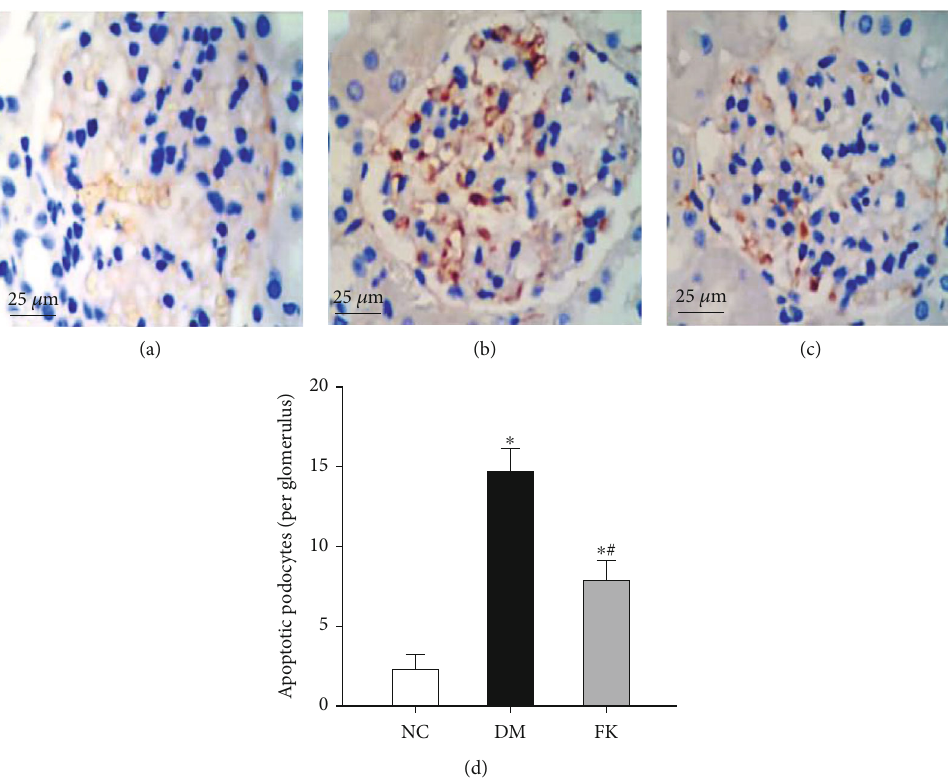
Figure 6: Podocyte apoptosis of rat renal tissues observed by TUNEL assay. (a) NC group, (b) DM group, and (c) FK group and (d) the counting of apoptotic podocytes per glomerulus in three groups. ∗ P < 0 : 05 compared to the NC group, ∗ # P < 0 : 05 compared to the DM